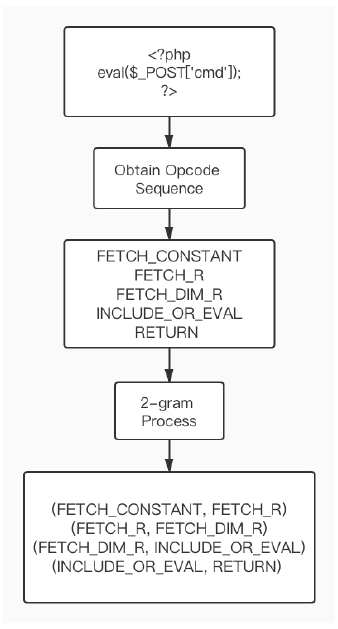
Figure 4. The webshell attack